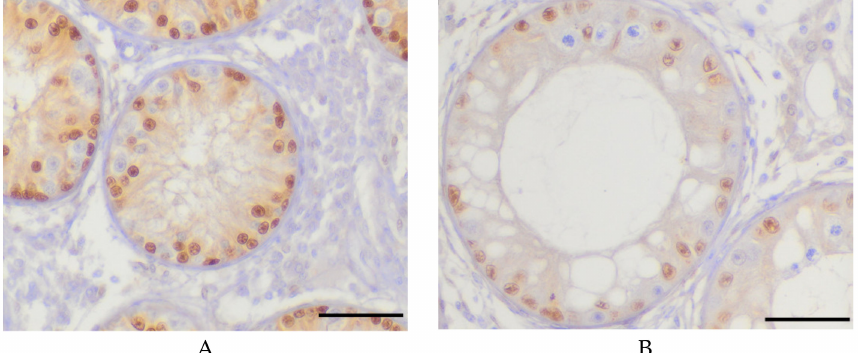
Figure 2. Representative immunohistochemical microphotographs of testicular tissue sections of en bloc samples from calves of the younger ( A : five months old) and older ( B : eight months old) age group. Scale bars = 50 µ m. The images represent SOX9 stained samples. SOX9 staining shows the brown coloring of the Sertoli cells (SC) nuclei and germ cells are immune-negative